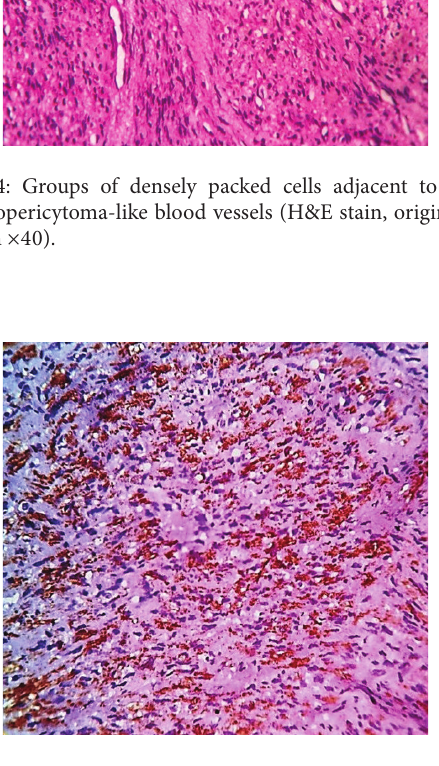
Figure 5: Bundles of lesional spindle cells intensely positive for alpha-smooth muscle actin (original magnification × 40).